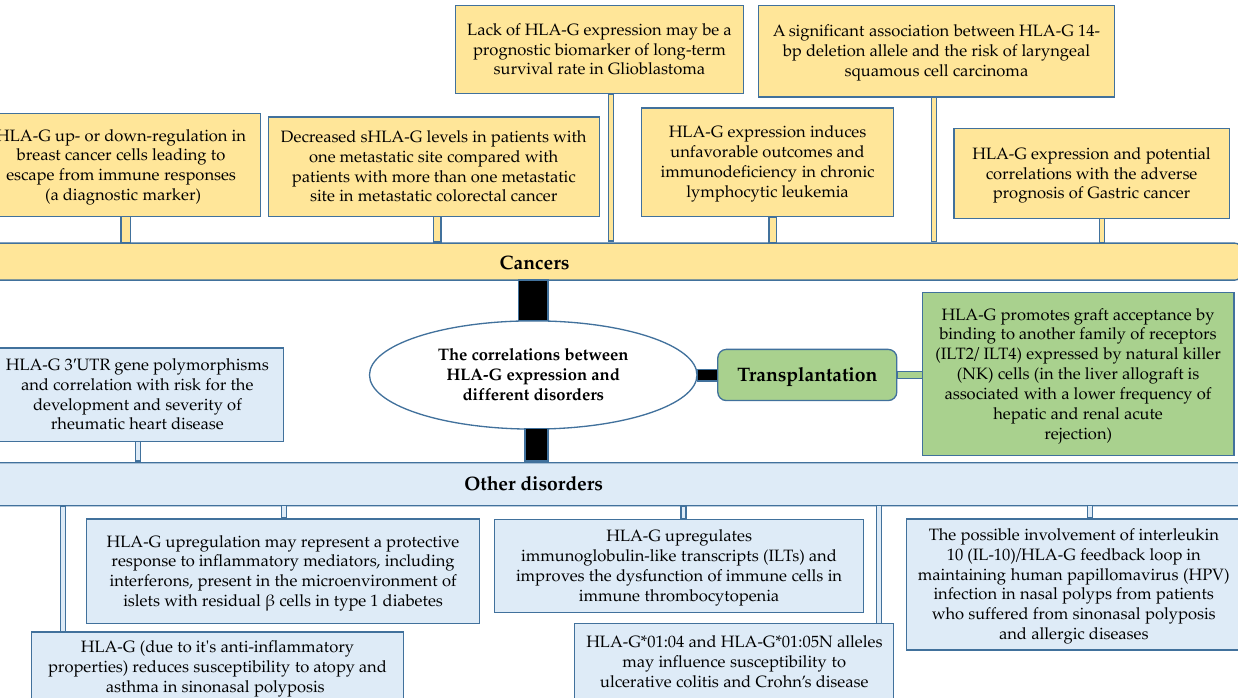
Figure 2. Correlation between HLA-G expression and different